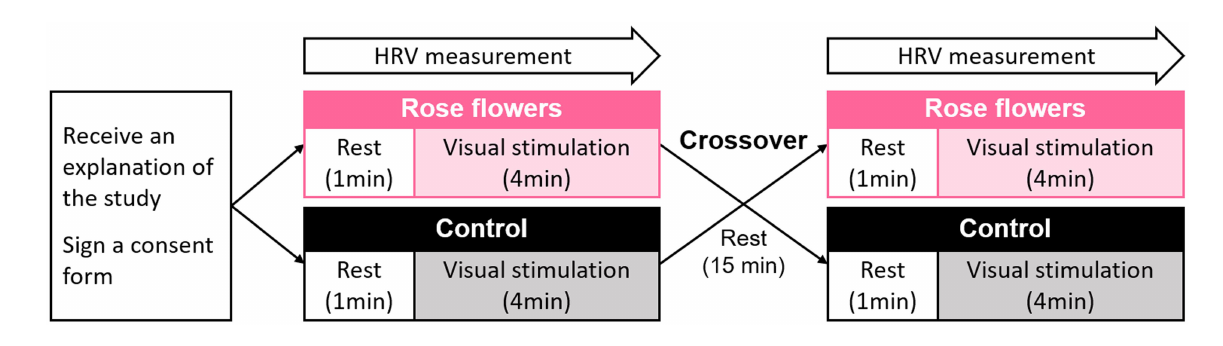
FIGURE 1 Design of the crossover study to measure the physiological adjustment effect of visual stimulation by fresh